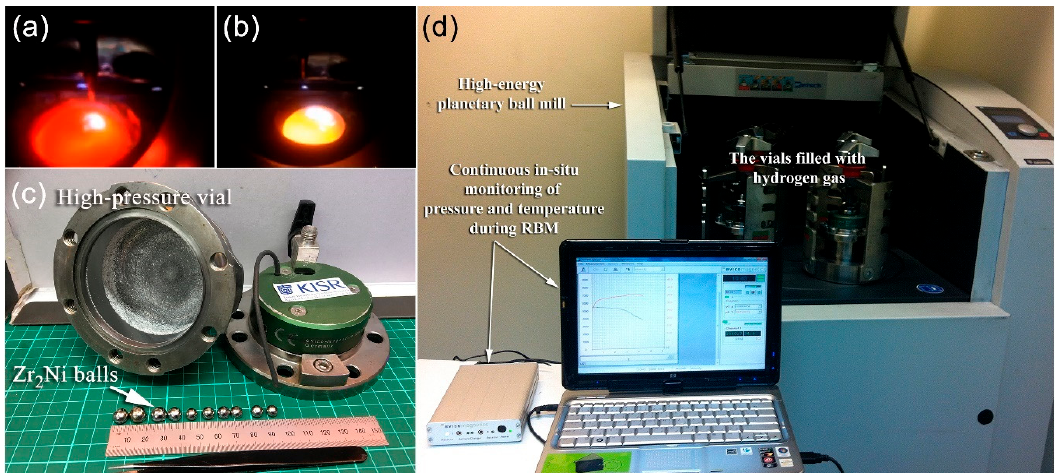
Figure 1. Bulk Zr and Ni (Zr 2 Ni) during ( a ) melting and ( b ) solidification in the He ‐ arc melter. The obtained Zr 2 Ni buttons were almost perfect spheres with nearly 10 mm in diameter ( c ). Zr 2 Ni balls ‐ milling media (50 pieces) were sealed in a 200 mL high ‐ pressure vial made of tool steel ( c ) together with different 5 g of Mg powders. The system was pressurized with 50 bar of hydrogen gas and then mounted on a planetary high-energy ball mill operated at room temperature for 25, 37.5 and 50 h of reactive ball milling (RBM) time ( d ). The experiments were repeated 2 − 4 times to ensure reproducibility of each milling run, using milling media (MM)-to-powder (P) weight ratio as 40:1.